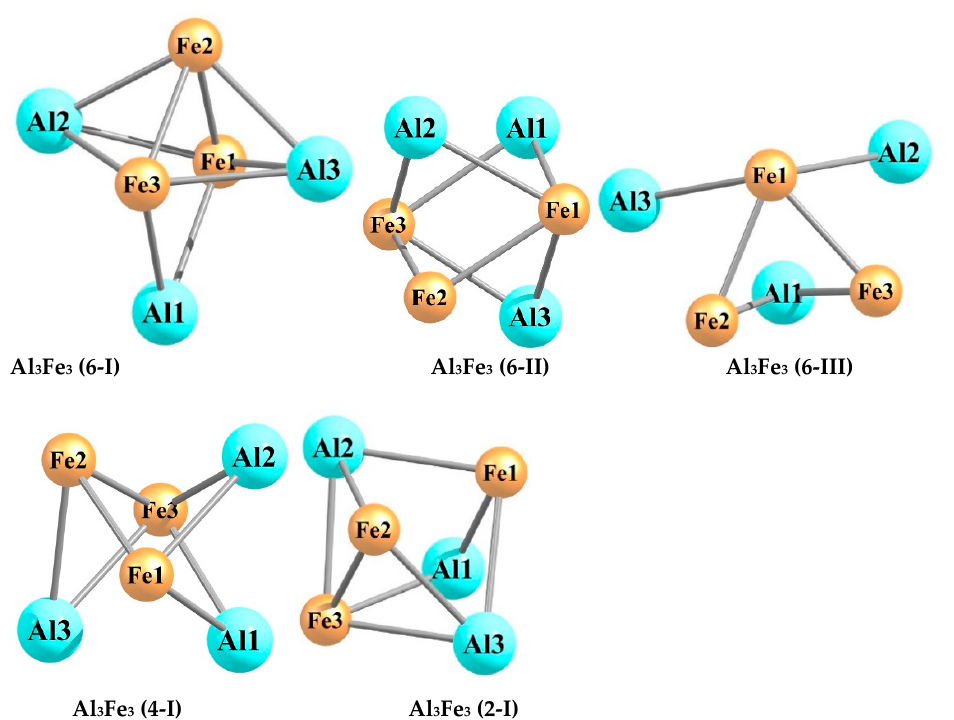
Figure 3. Molecular structures of the five most energetically stable Al 3 Fe 3 metal clusters. Table 6. Key structural parameters of the most stable Al 3 Fe 3 metal clusters.